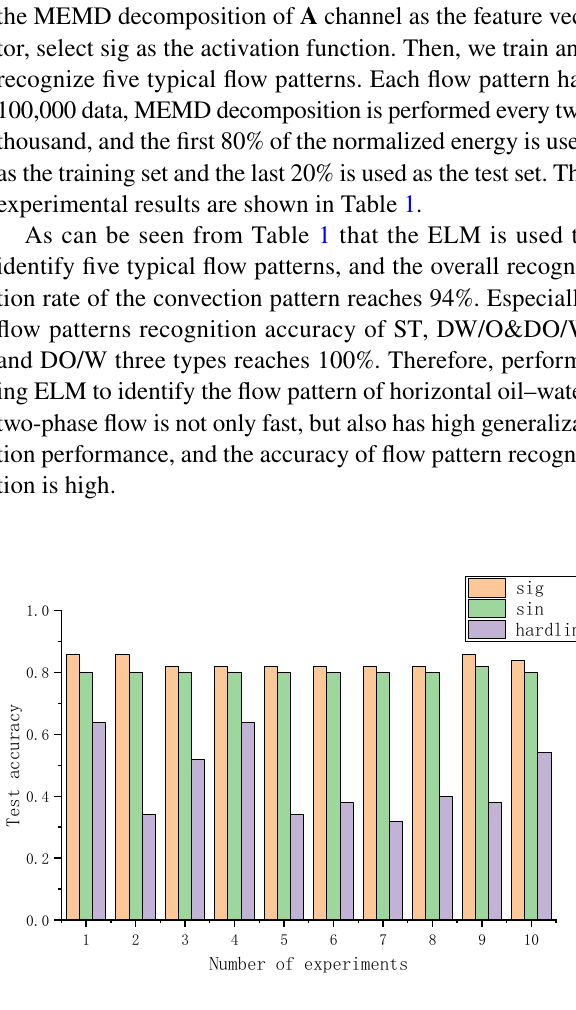
Fig. 7 Recognition rate of test set with different activation functions